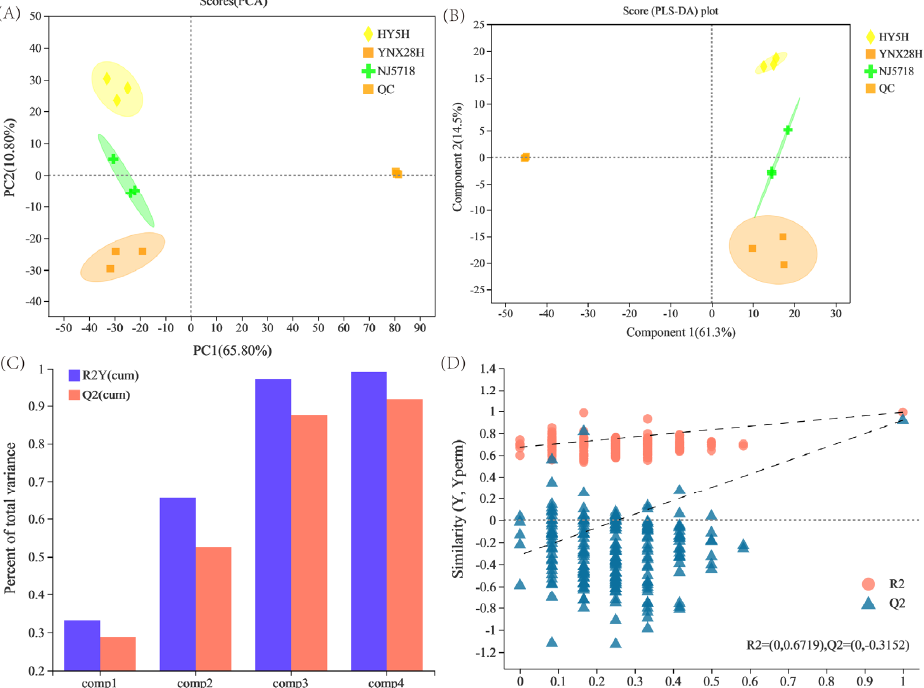
Figure 1. Testing for permutations and multivariate statistical scores among the three japonica rice varieties. ( A ) PCA, ( B ) PLS-DA, ( C ) overview of the PLS-DA model, and ( D ) PLS-DA permutation testing. PCA, principal component analysis; PC, principal component; PLS-DA, partial least squares discriminant analysis; HY5H, Hongyang 5 hao; YNX28H, Yangnongxiang 28; NJ5718, Nanjing 5718.